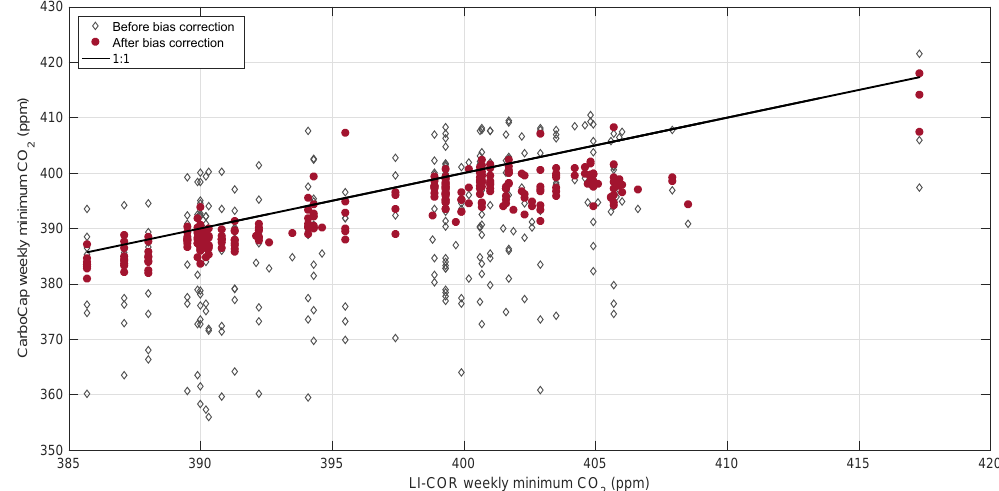
Figure 8. Weekly minimum CO 2 concentrations measured by a LI-COR LI-820 reference instrument compared with weekly minima calcu- lated from the BEACO 2 N data record before and after correction for systematic uncertainties.